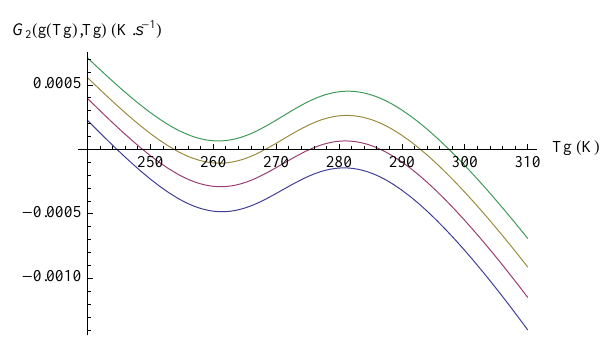
Fig. 4. Function G 2 (g(T g ), T g ) as a function of T g (see text) in- cluding the ice-albedo feedback for different values of the solar constant: 0.95 S 0 (blue), S 0 (red), 1.05 S 0 (yellow), 1.1 S 0 (green).